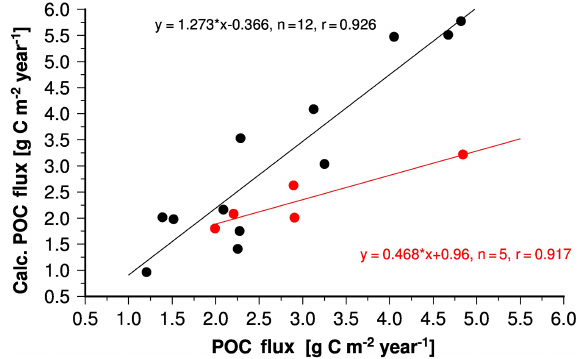
Figure 10. Calculated versus measured annual mean organic car- bon fluxes. In addition to export production derived from primary production and the modified Eq. (3) a constant sinking speed of 224mday − 1 was used to calculate organic carbon fluxes. Black and red circles indicate data obtained at sites characterised by low (<25%) and high lithogenic matter content (>25%),